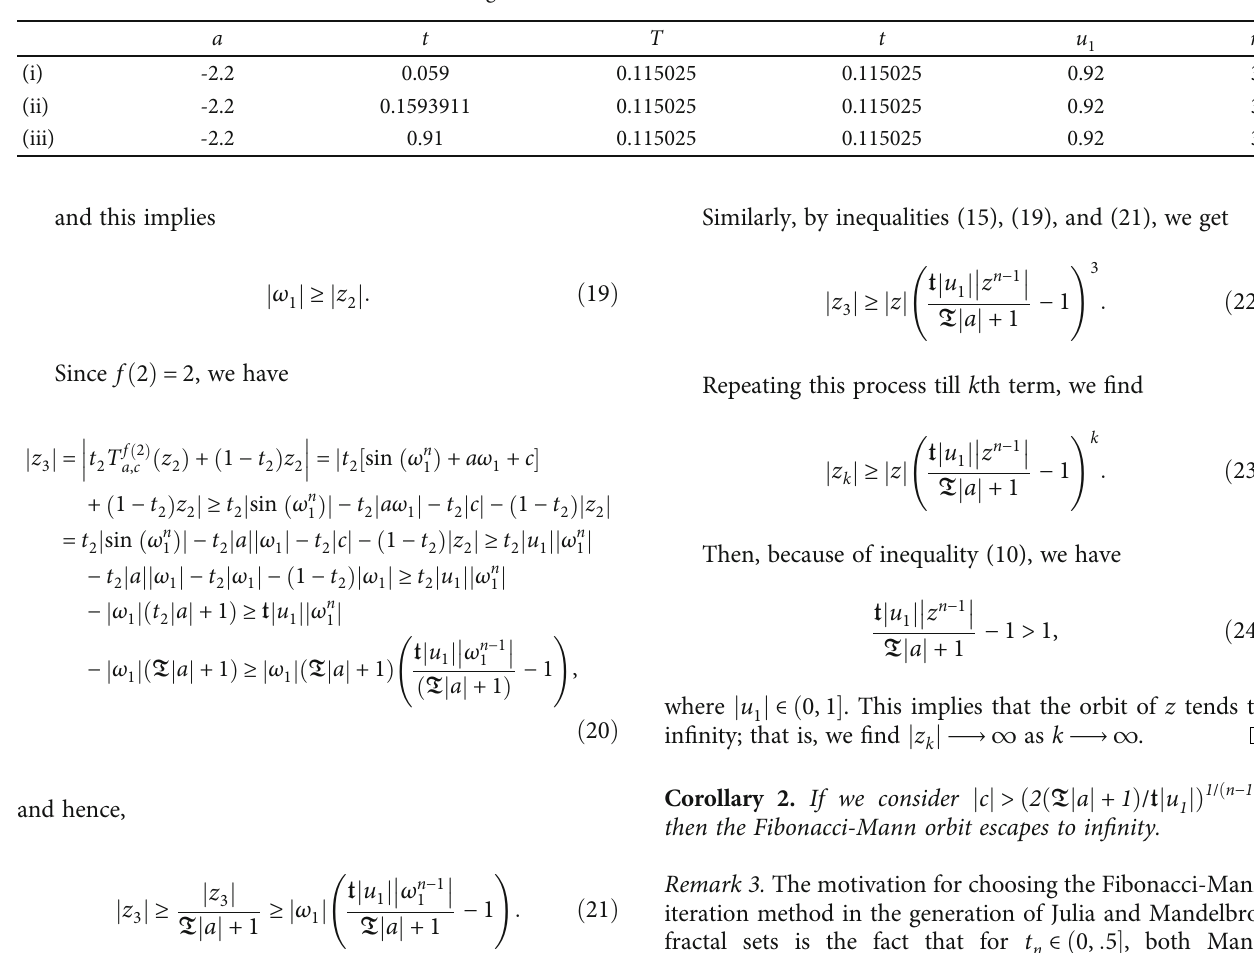
Table 9: Parameters for generation of cubic Mandelbrot set for di ff erent values of t